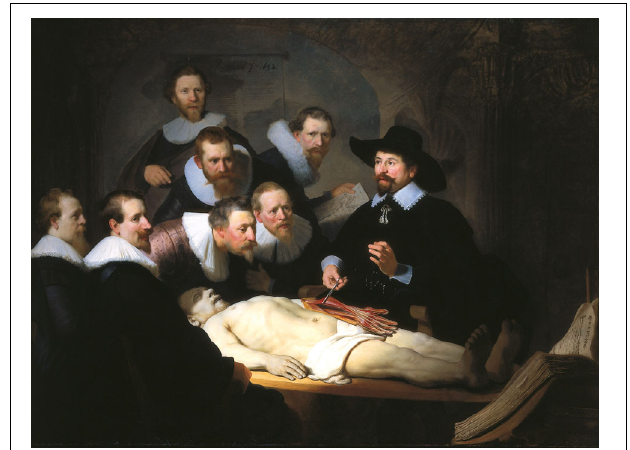
FIGURE 2 | Reproduction of “The Anatomy Lesson of Dr. Nicolaes Tulp” (1632), Rembrandt van Rijn:’s-Gravenhage, Mauritshuis, Netherlands. Image in public